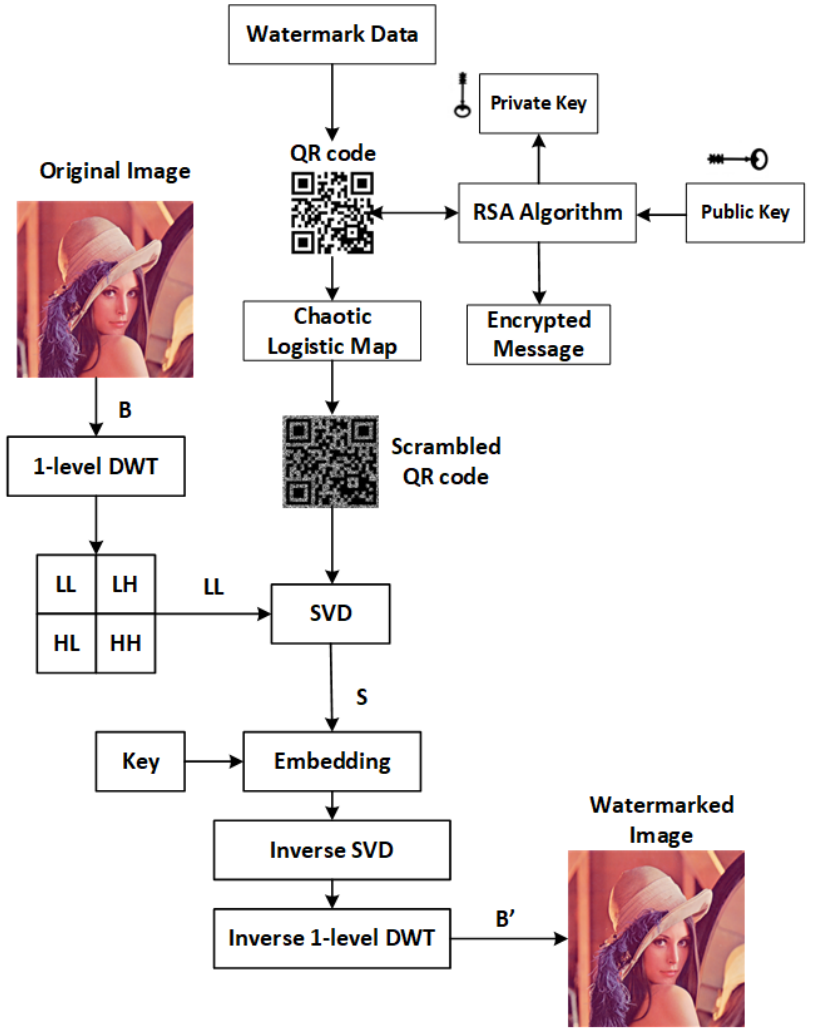
Figure 4. The proposed scheme: embedding